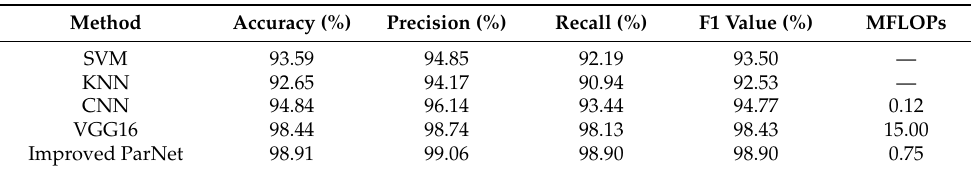
Table 4. Recognition effect of different recognition